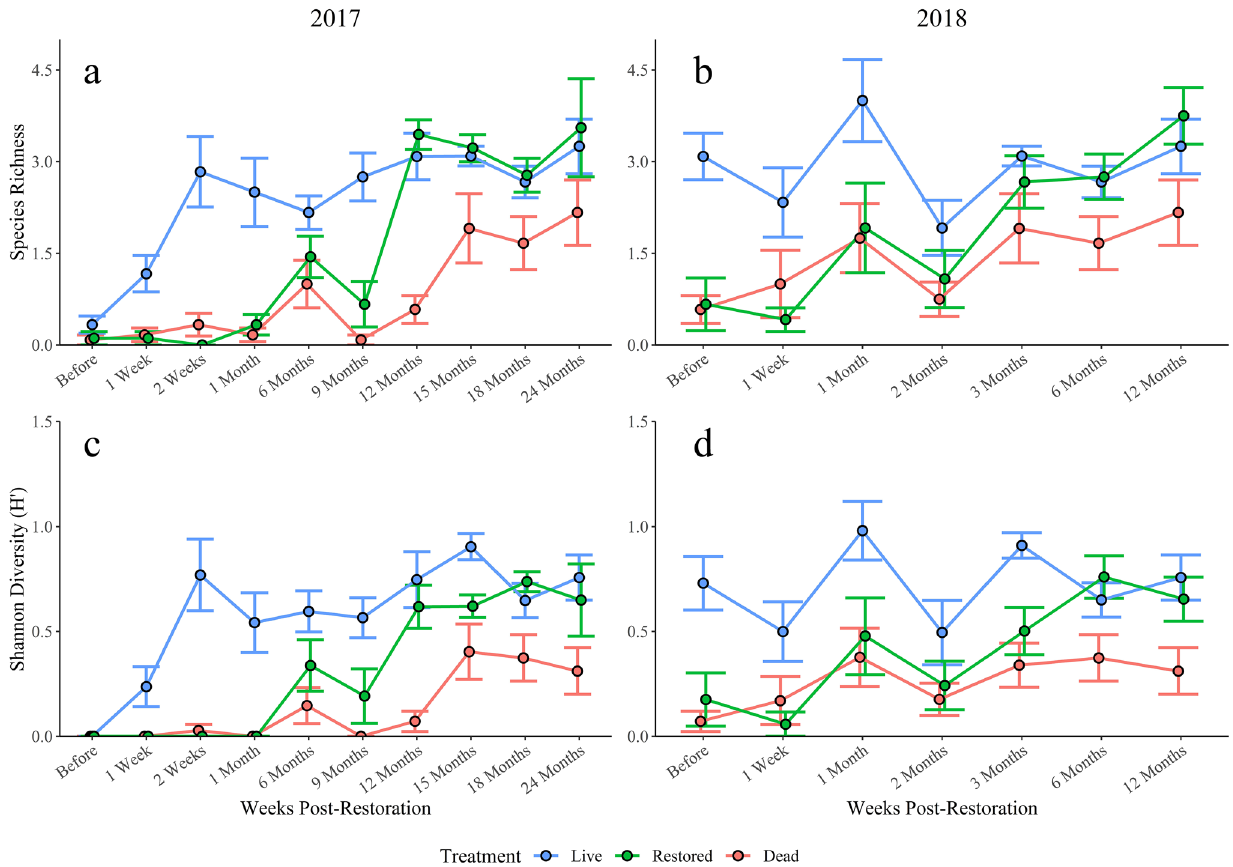
Figure 1. Species richness (top row) and Shannon diversity (bottom row) on 2017 (left) and 2018 (right) reefs. Error is shown for each treatment-time point as ± SE. Species richness and Shannon diversity on restored reefs recovered to states equivalent to those on life reefs as soon as 6 months after restoration. Diversity indices recovered fully by 12 months post-restoration and mirrored live reefs for the remainder of the study.